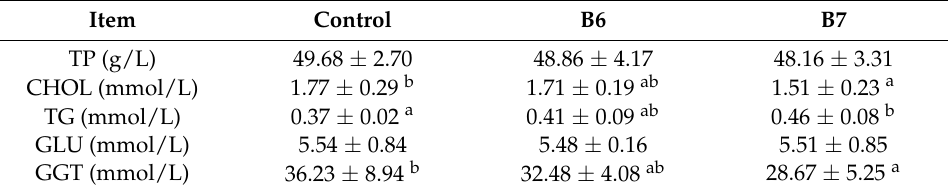
Table 2. Effects of B. coagulans on plasma biochemical indicators of weaned